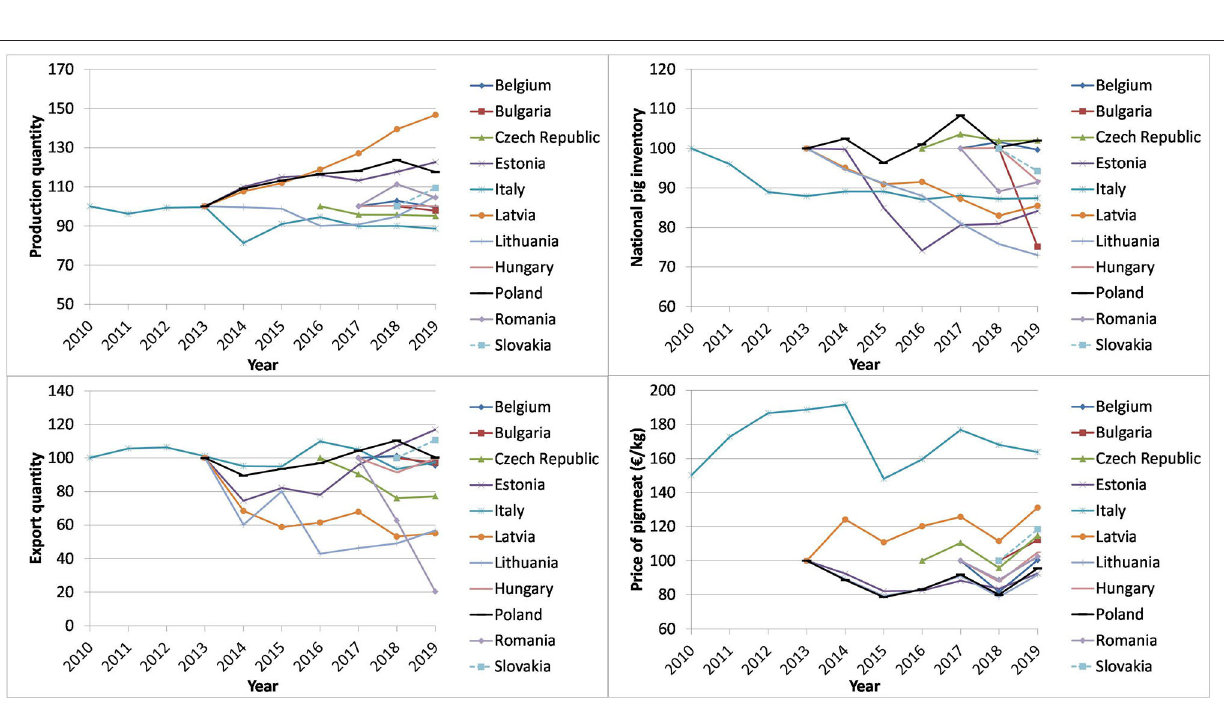
FIGURE 2 | The evolution of the quantity of pigmeat produced, the national pig inventory, the quantity of exported pigmeat (value in the year before ASF was observed in the country = 100), and the price of pigmeat (class E, e /kg) in the study countries starting from the year before ASF was observed in each country. Sources: Eurostat, the European